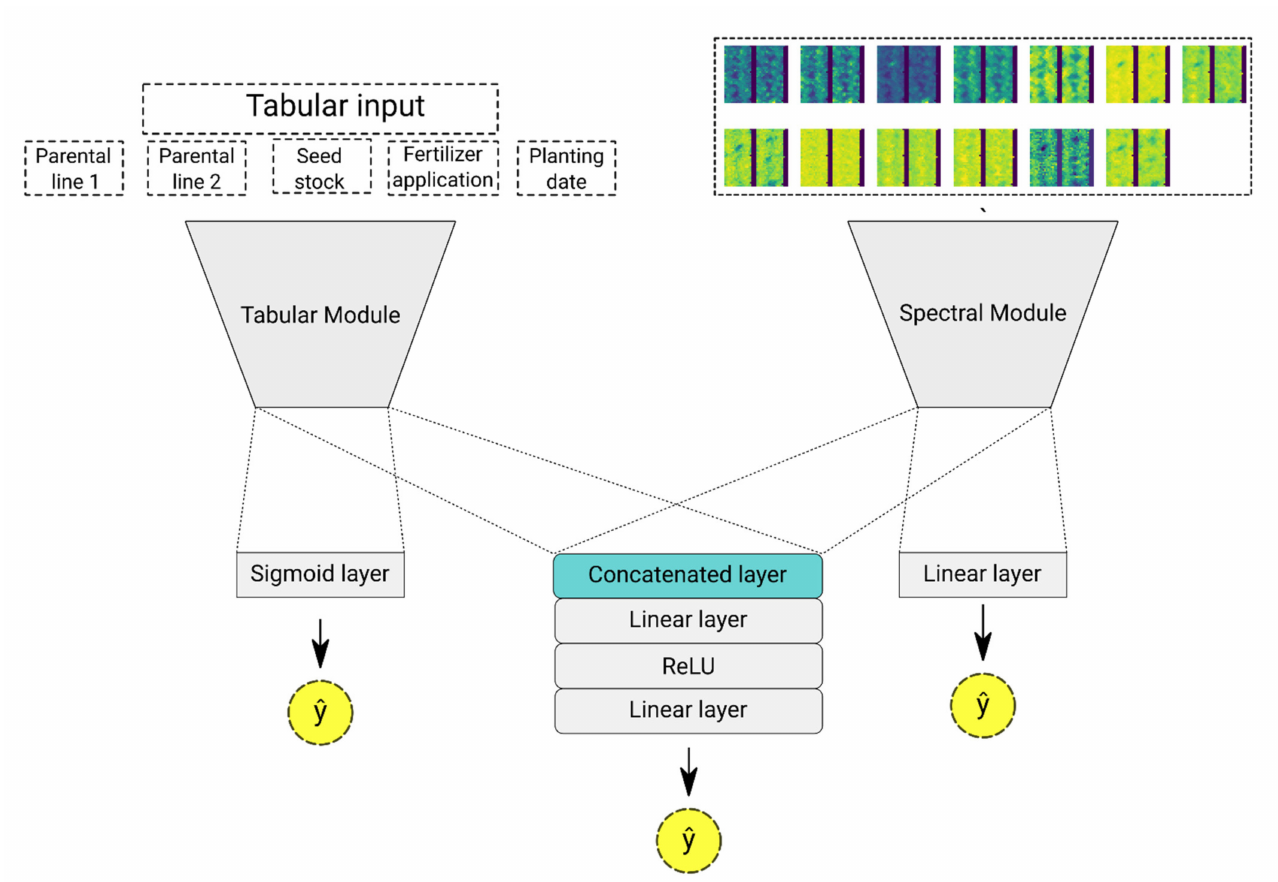
Figure 3. Scheme showing the multimodal model architecture. The tab-DNN and sp-DNN models output an independent yield prediction value (ˆy) based on their respective input datasets. The weights from the last layer of the tab-DNN and sp-DNN are combined to feed the fusion module, which outputs the multimodal yield prediction